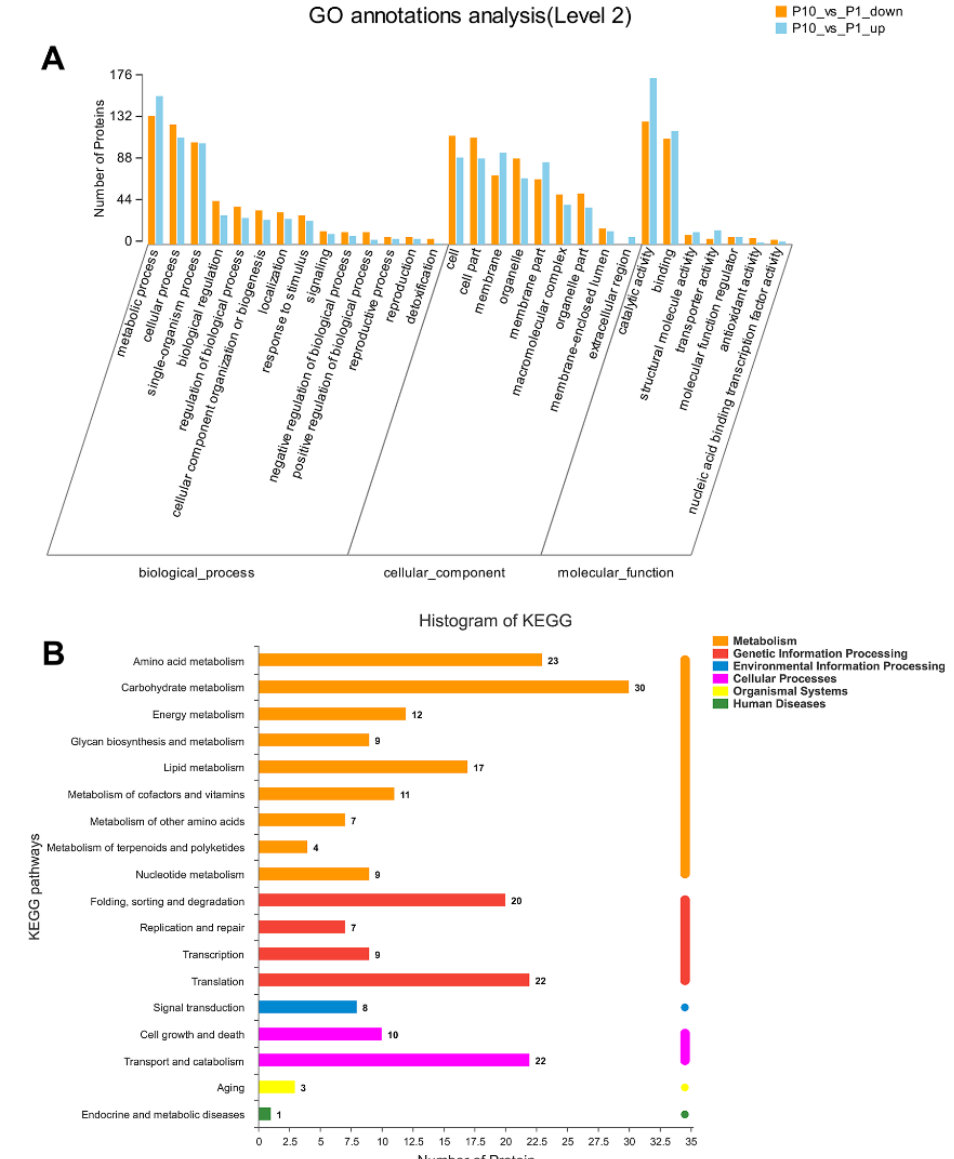
Figure 2. GO and Kyoto Encyclopedia of Genes and Genomes (KEGG) annotation of all the DEPs in Pleurotus ostreatus . GO annotation of the DEPs in level 2 with the up-regulated proteins in orange column and down-regulated proteins in blue column, respectively ( A ). KEGG pathway of all the DEPs was mapped into different processes ( B ).